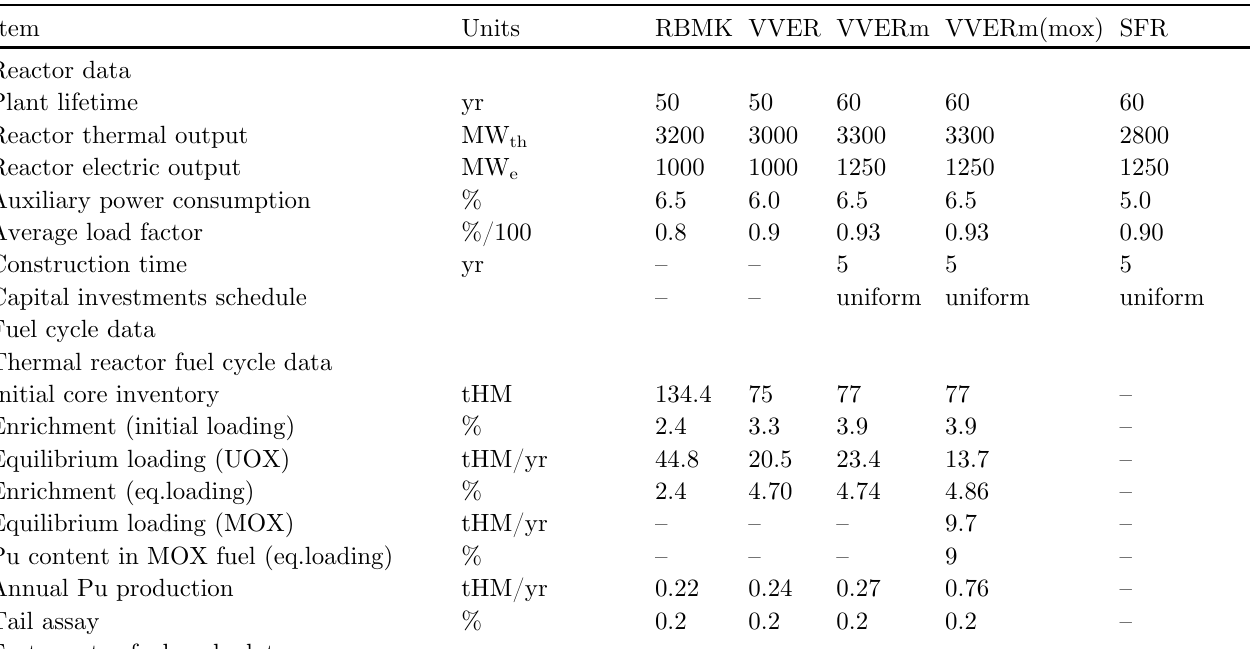
Table B.1. Reactor and fuel cycle